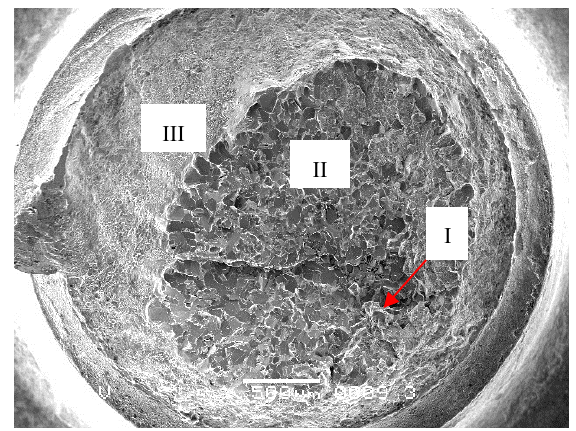
Figure 5. Low magnification of fracture surface of the #4 screw (500 μ m).